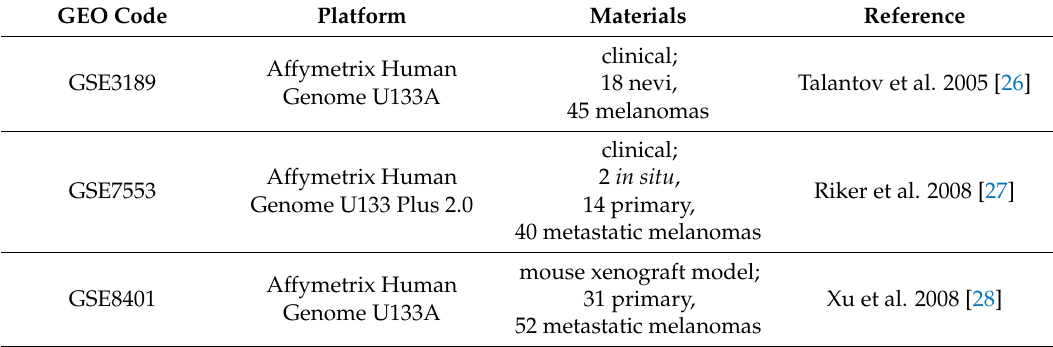
Table 1. Connexin mRNA expression data of relevant melanocytic tissue lesions found in GEO (Gene Expression Omnibus) database.